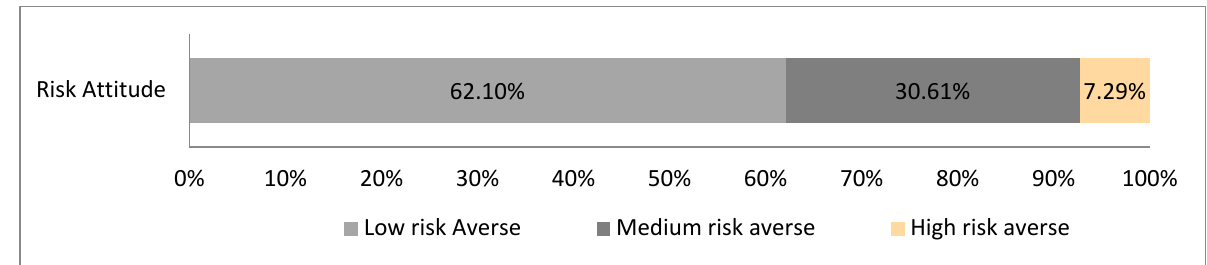
Figure 5. Risk aversion behaviour of maize producers.